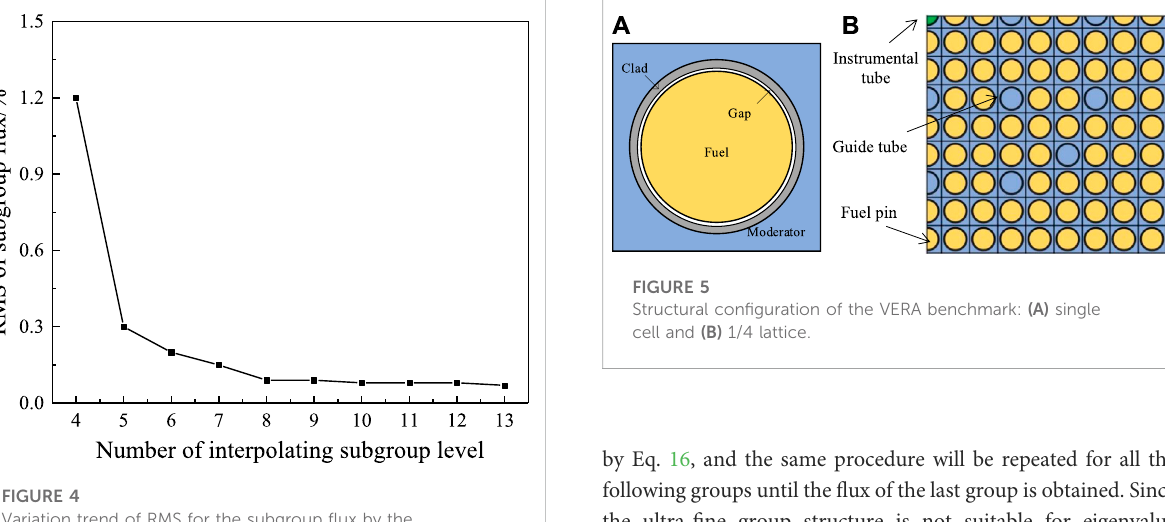
FIGURE 4 Variation trend of RMS for the subgroup fl ux by the interpolating number of subgroup levels.